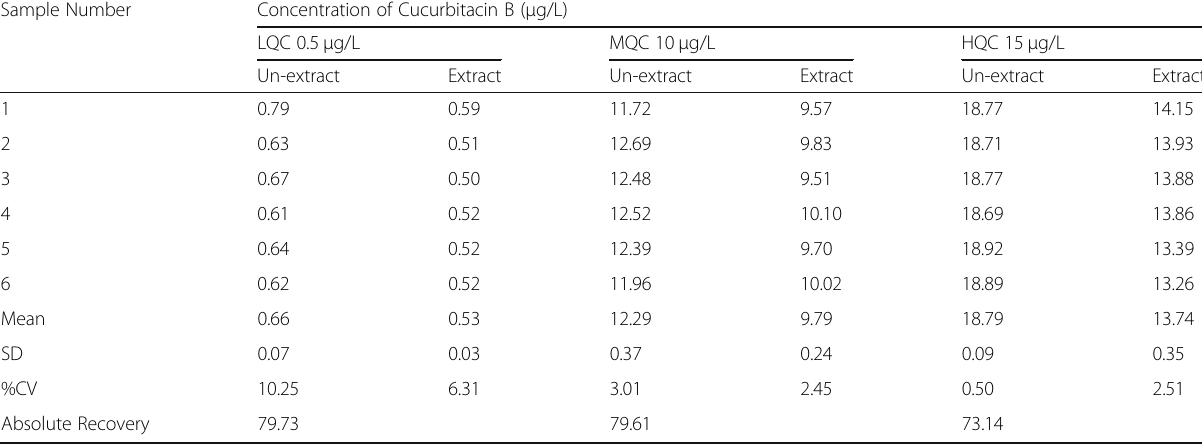
Table 3 The recovery of cucurbitacin B after extraction from rat plasma Sample Number